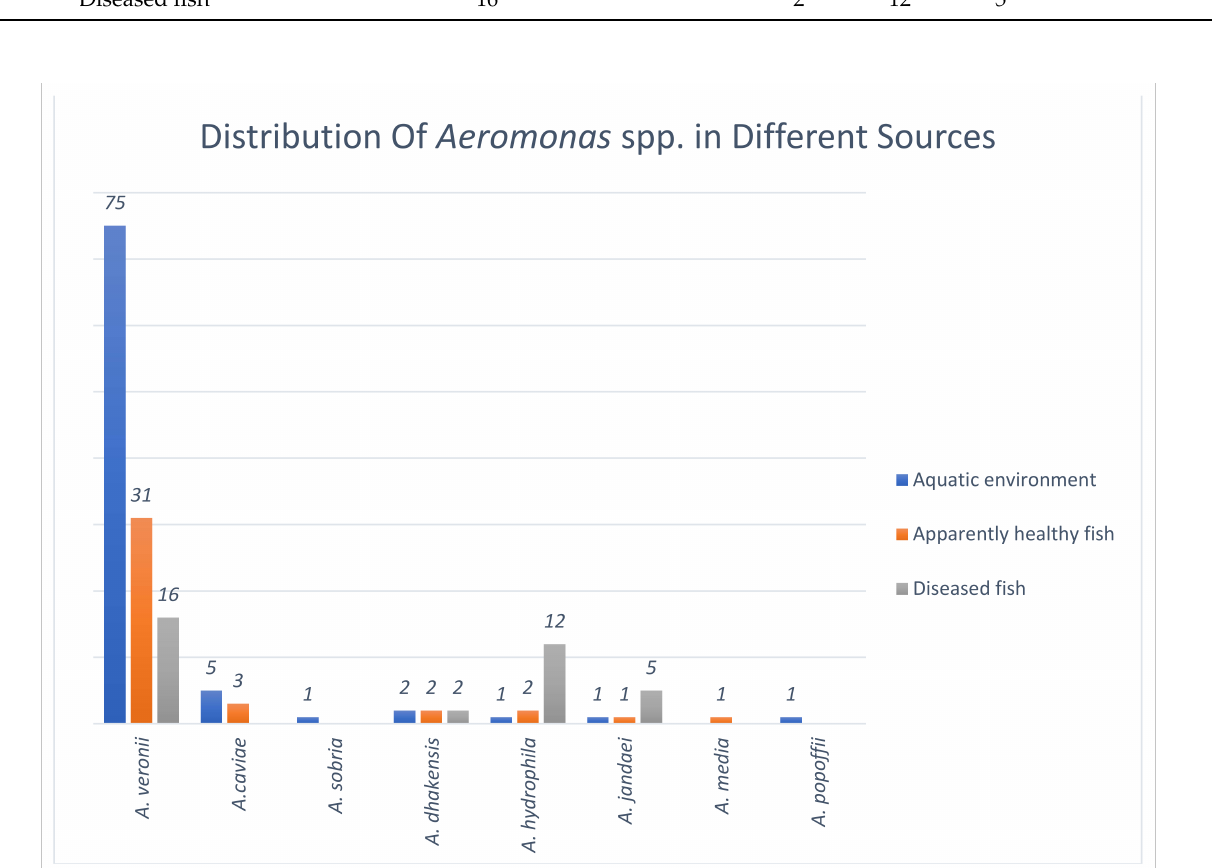
Figure 1. Distribution of Aeromonas species in the aquatic environment, apparently healthy and diseased ornamental